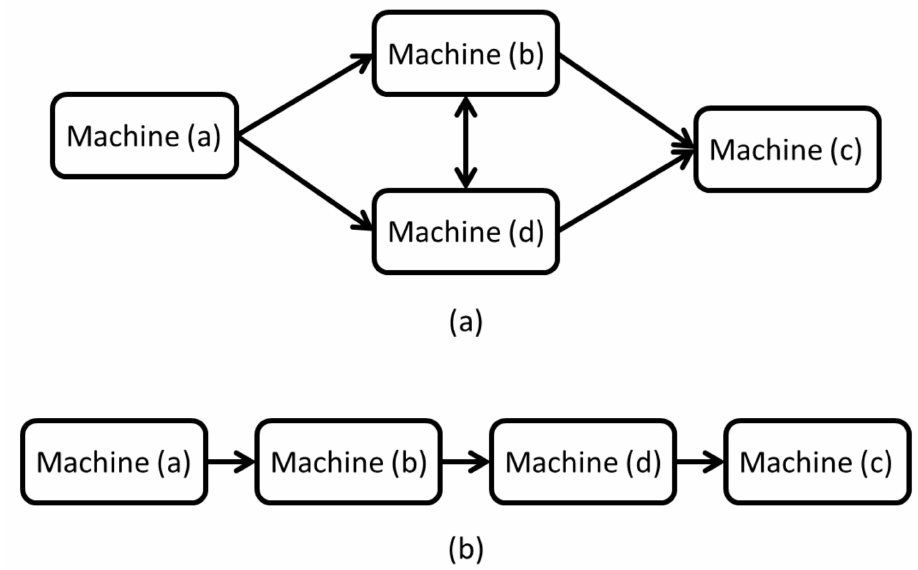
Figure 8. Ideal ( a ) and actual ( b ) collaboration between machines ( a – d